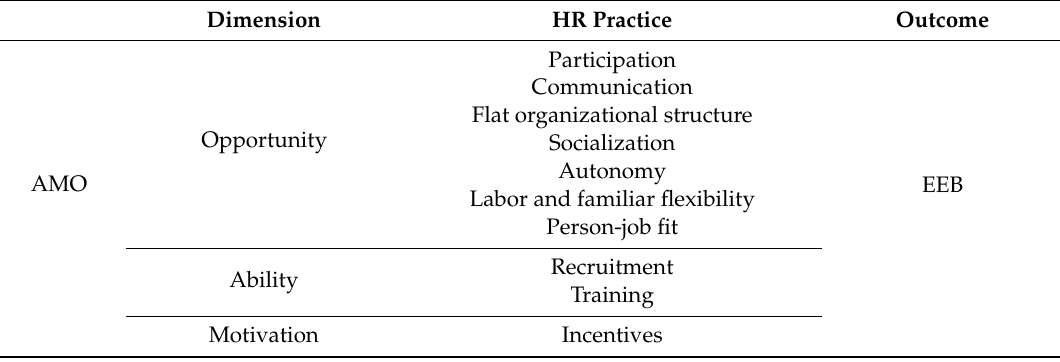
Table 5. Practices implemented by INVs to foster